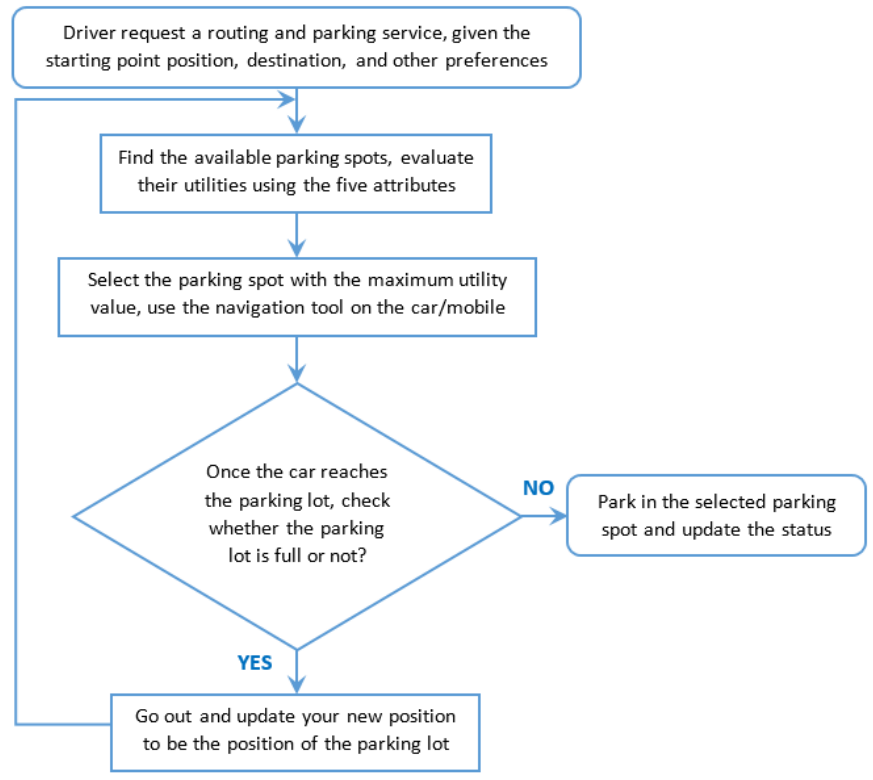
Figure 2. Diagram of the multiple objectives